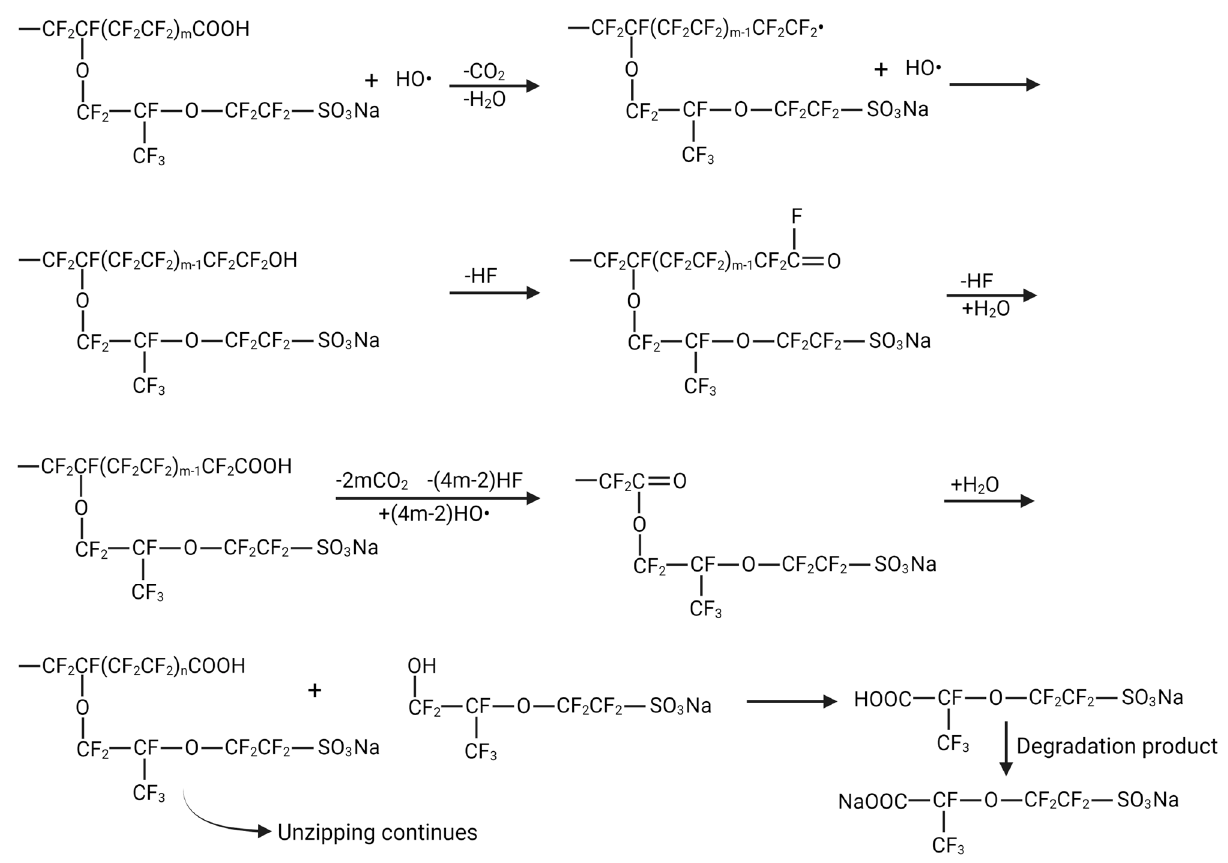
Figure 8. Schematic of the main chain unzipping process.